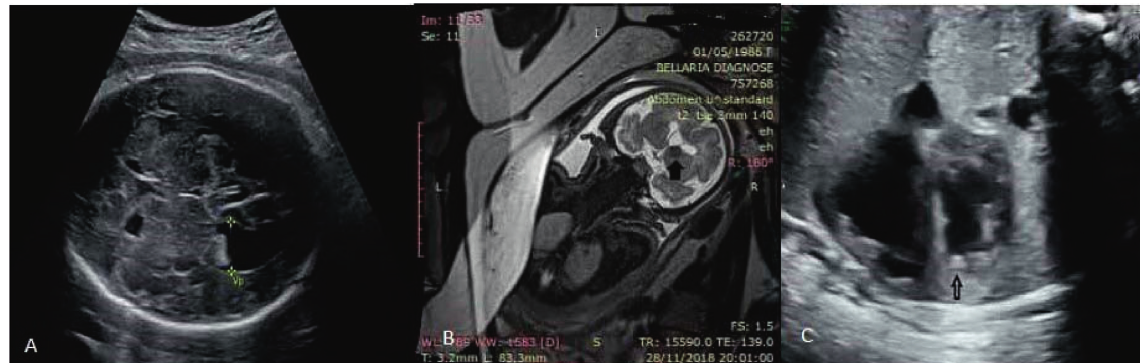
Figure 1: (a) Fetal ultrasound—bilateral hydrocephalus, mild on the right side and severe on the left side; (b) fetal MRI—lesion next to the foramen of Monro, typical for SEGA; (c) fetal ultrasound—echogenic intracardiac focus on the left ventricular apex.